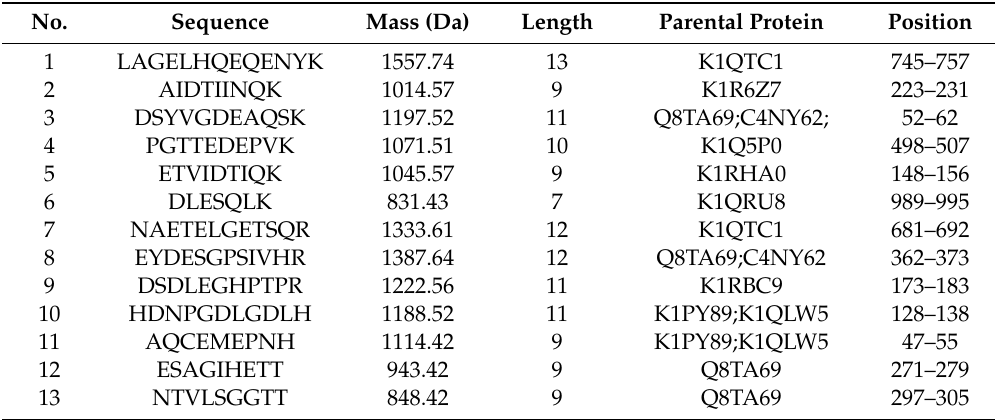
Table 5. The peptide sequences of F2.